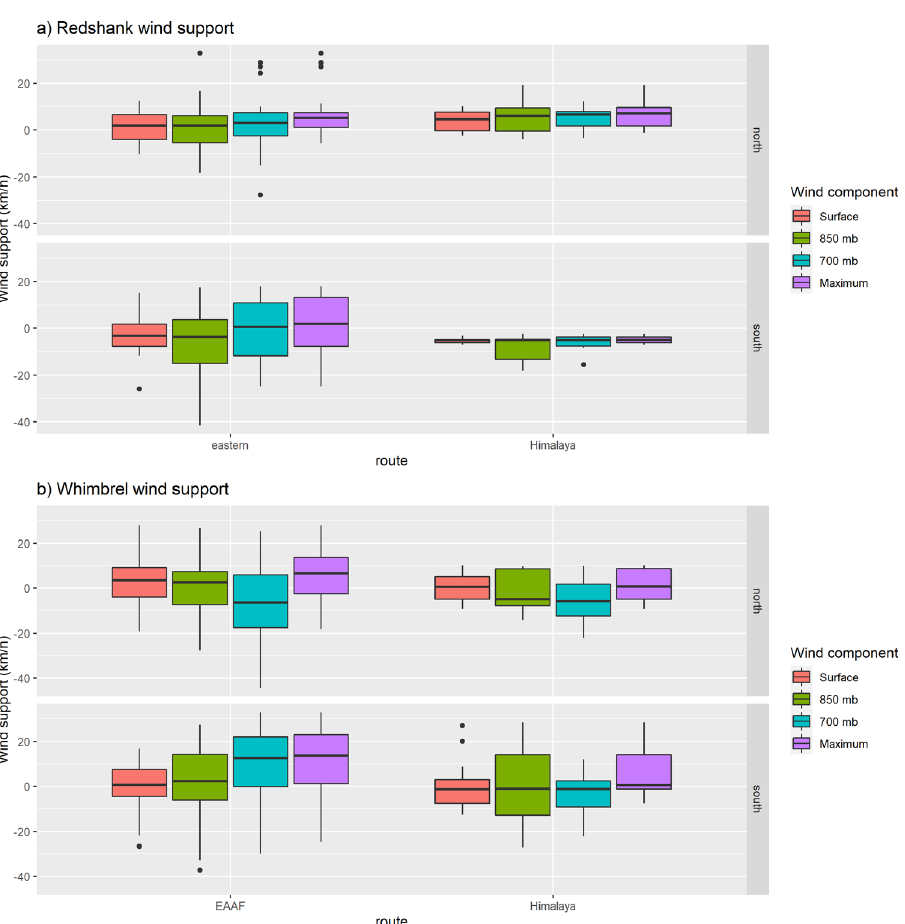
Figure 6. Wind support for Common Redshanks and Whimbrels migrating along trans-Himalayan or eastern routes from Singapore on northward and southward migration. Winds were estimated at three elevations along routes derived from geolocators (nine tracks of eight Redshanks in 2015 and 2016) or satellite transmitters (four tracks of three Redshanks and eight tracks of five Whimbrels in 2018 and